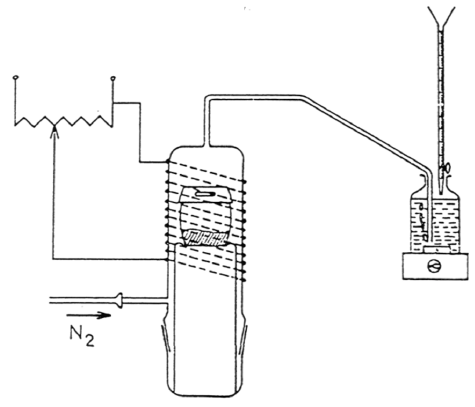
Figure 1. Device used for nitrogen determination.